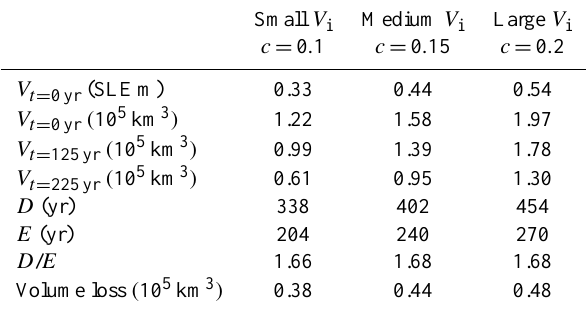
Table 3. Results of fits on the evolution of V (Eq. 5) for 3 values of c (Eq. 1), using the R10 data. V t = 0yr represents the 1865 volume, V t = 125yr the 1990 volume, V t = 225yr the 2090 volume, D and E are fitted constants in yr. Sea-level equivalent (SLE) is calculated assuming an ocean area of 3 . 62 × 10 8 km 2